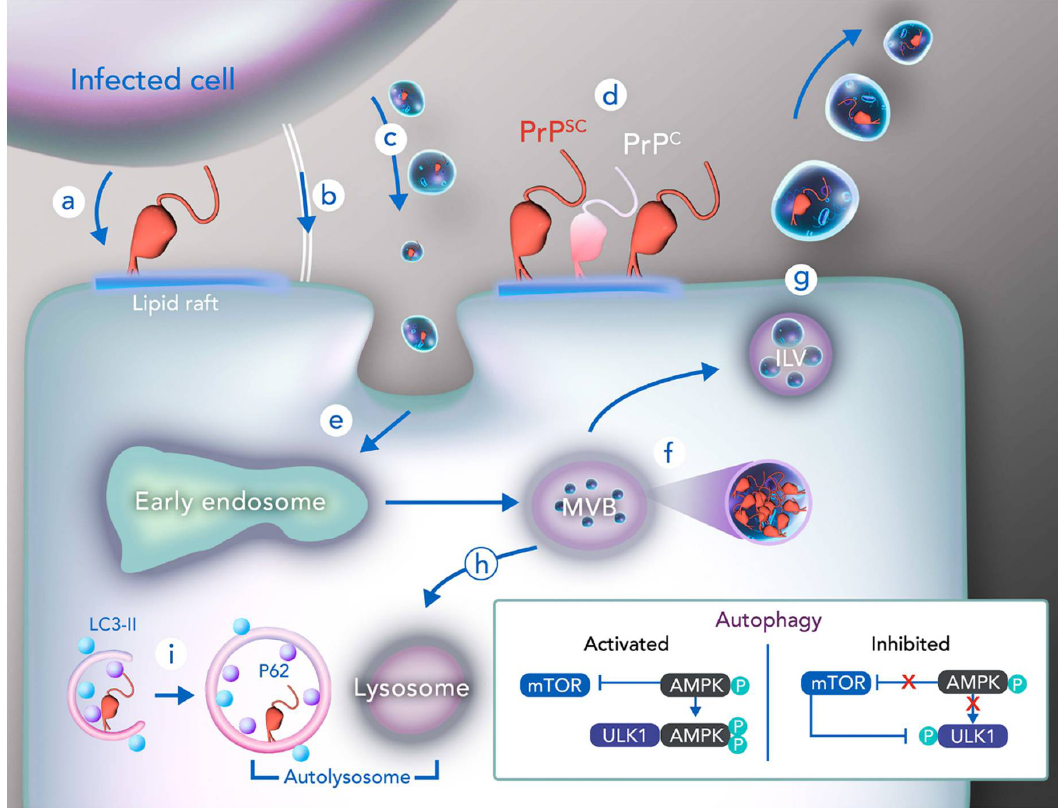
Figure 2. Prion infection mechanisms and PrP Sc processing through autophagy. PrP Sc is capable of catalyzing the conversion of PrP C into the infectious isoform PrP Sc , and its spreading is highly dependent on PrP C trafficking throughout different mechanisms, such as ( A ) prion infection through GPI-painting, in which PrP Sc from an infected cell attaches to the lipid rafts of another cell; ( B ) prion infection through tunneling nanotubes, including transfer of endolysosomal vesicles in these structures; and ( C ) prion infection via exosomes, occurring in different cells types. It is postulated that PrP C -PrP Sc conversion starts on the cell membrane ( D ) and continues throughout the endocytic trafficking ( E – G ). Once PrP Sc -containing exosomes fuse with the surface of other cell membrane ( E ), PrP Sc can be directed to different endocytic vesicles. Multivesicular bodies (MVBs) can carry PrP Sc to the autophagosomal/lysosomal degradation pathway ( H ), or to intraluminal vesicles (ILVs) to be secreted as exosomes ( G ). Under physiological conditions, mTOR is inhibited via AMPK phosphorylation, and PrP Sc is sorted into the autophagosome (identified by markers p62 and LC3), being degraded after autophago-lysosomal fusion (forming the autolysosome) (inset: T bars represent pathway inhibition ) ( I ). However, in prion-like diseases, mTOR inhibits the interaction between ULK1 and AMPK through phosphorylation of ULK1, leading to the impairment of autophagy and PrP Sc clearance (bottom right